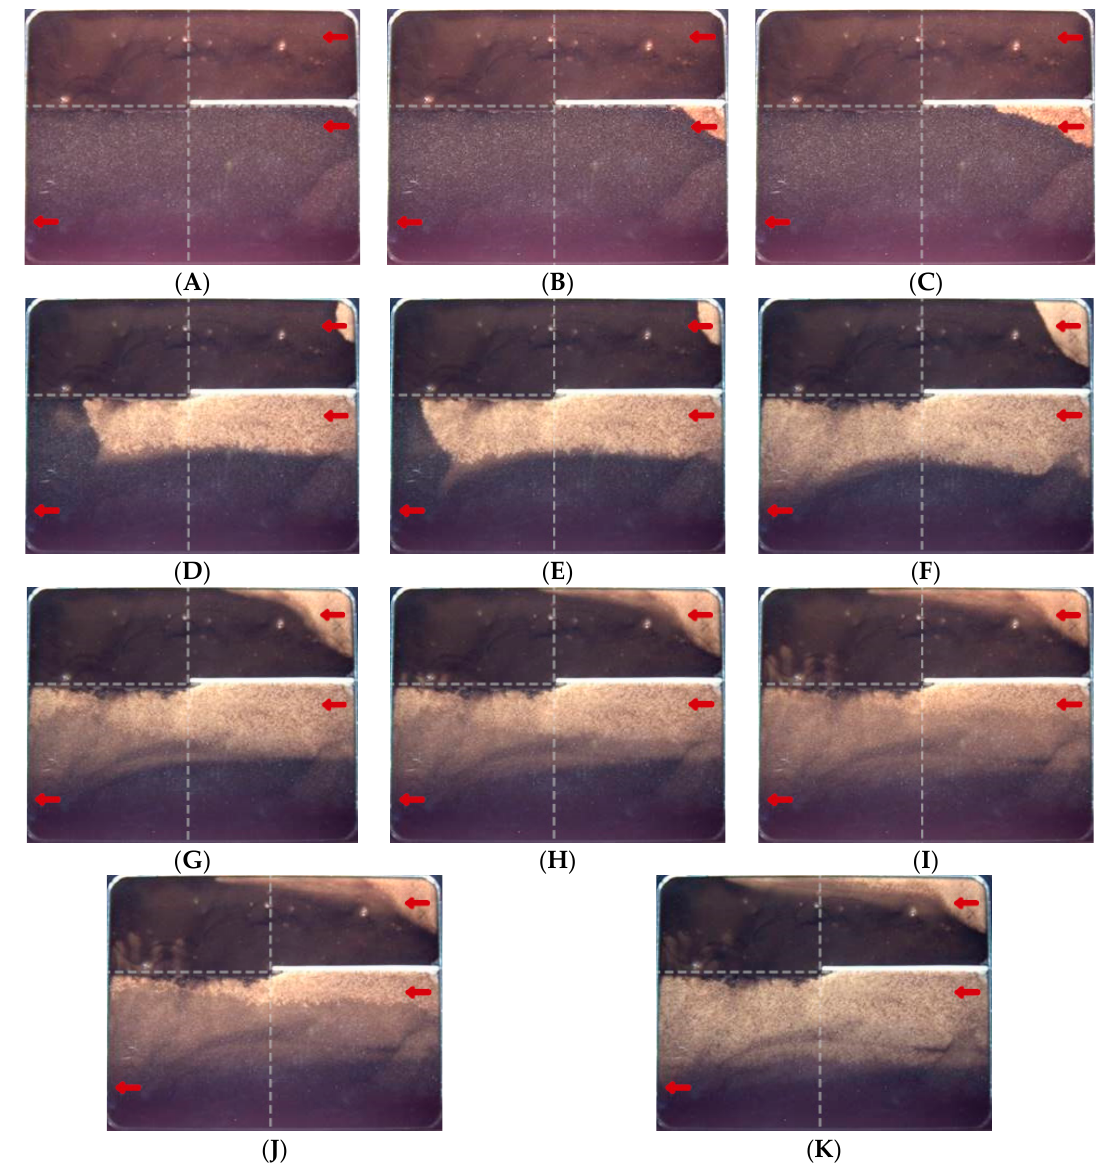
Figure 5. State diagram of CO 2 miscible flooding at different production time. ( A ) 0 min; ( B ) 1 min; ( C ) 2 min; ( D ) 20 min; ( E ) 24 min; (gas breakthrough); ( F ) 34 min; ( G ) 74 min; ( H ) 164 min; ( I ) 344 min; ( J ) 358 min (increasing oil production rate); ( K ) 468 min (end of experiment). (The arrow at the right side is the injection end; the arrow at the left side is the production end)